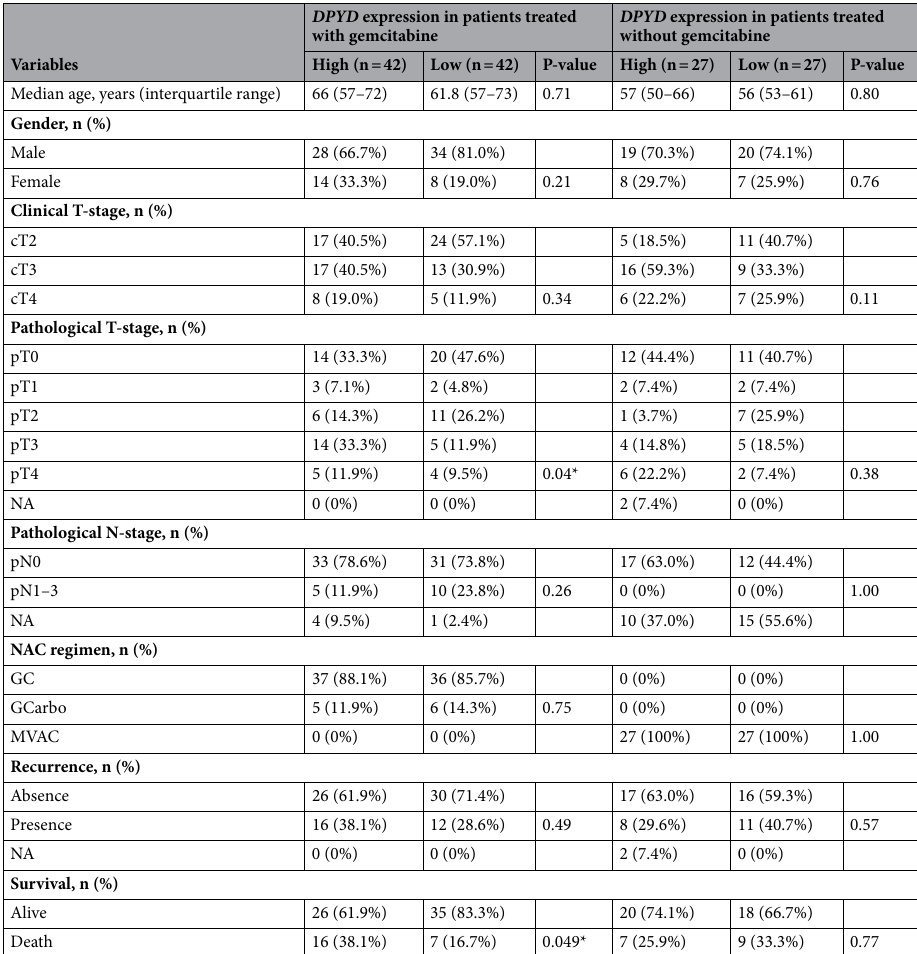
Table 1. Clinicopathological information of patients. NA, not available; NAC, neoadjuvant chemotherapy; GC, gemcitabine/cisplatin; Gcarbo, gemcitabine/carboplatin; MVAC, methotrexate/vinblastine/doxorubicin/ cisplatin. *Statistically